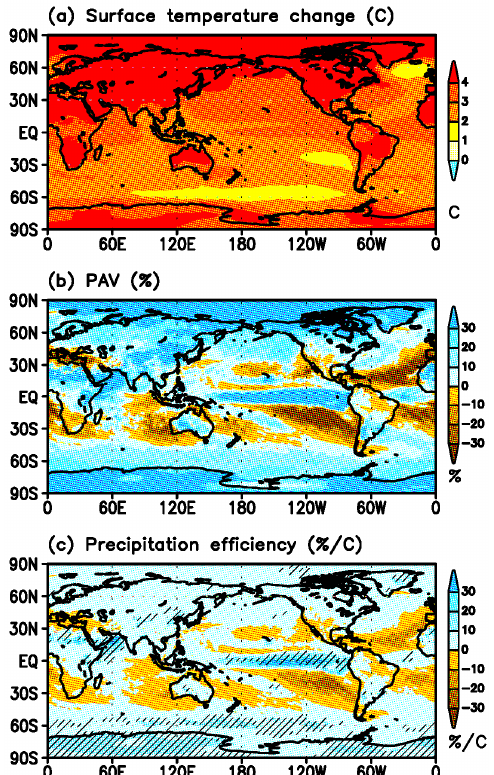
Figure 9. Precipitation efficiency calculated at each grid point. ( a ) Change in annual mean surface air temperature ( ◦ C) by HFYSC0 (2079–2099) from the HPYS (1983–2003); ( b ) PAV change (%) by HFYSC0 relative to HPYS; ( c ) precipitation efficiency (%/ ◦ C) defined as PAV change ( b ) divided by surface air temperature change (a). Hatched regions indicate that precipitation efficiency is larger than the rate of precipitation increase (7.5%/ ◦ C) expected from the Clausius–Clapeyron (C-C) relationship.